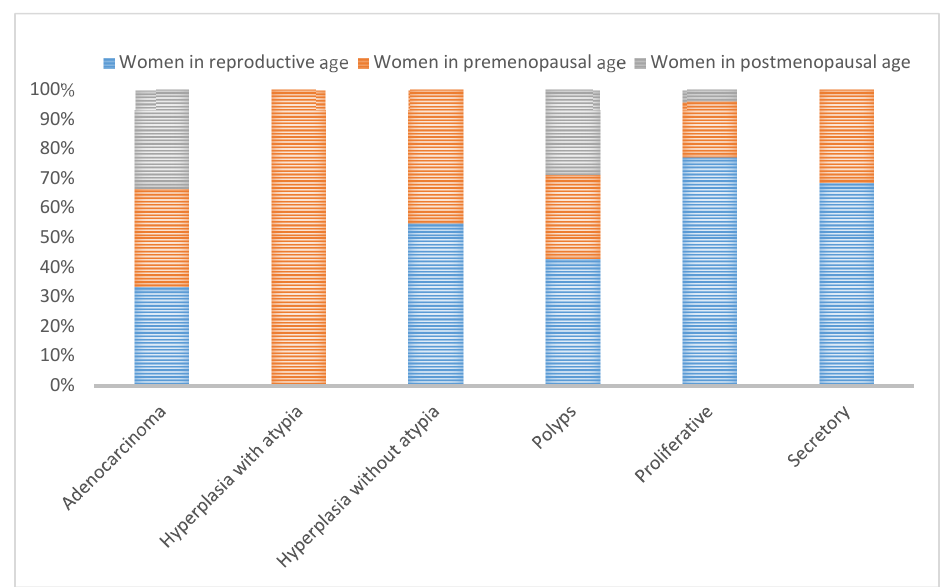
Figure 1. Results of histopathological diagnosis of endometrial samples by age group (Pipelle biopsy).